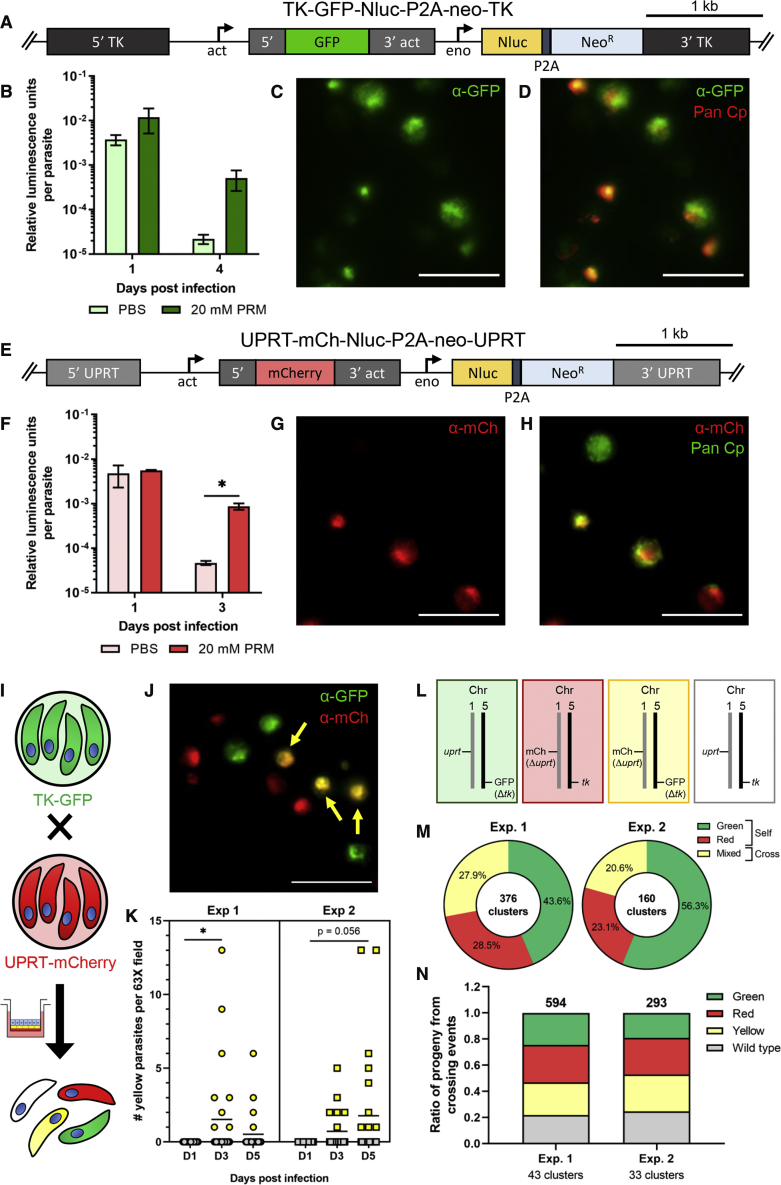
ALI Transwells support genetic crosses of C. parvum in vitro(A) Diagram of targeting construct designed to replace the endogenous tk locus (cgd5_4440) with GFP and Nluc-P2A-NeoR cassette.(B) Relative luminescence normalized to total number of parasites in ALI transwells at 1 and 4 days post infection (dpi). Transwells were infected with ∼1 × 107 unfiltered sporozoites that were electroporated with the TK-GFP-Nluc-P2A-neo-TK reporter and a Cas9 plasmid with a TK gRNA. Transwells were cultured in medium containing PBS (light green) as a control or 20 mM paromomycin (PRM, dark green). Data plotted as mean ± S.D. from two transwells per time point from a representative experiment. Nonsignificant (p = 0.11), unpaired Student’s t test between PBS and PRM-treated transwells 4 dpi.(C) Image of whole-mount ALI transwells 5 dpi with transfected C. parvum from same experiment as (B) stained with anti-GFP followed by goat anti-rabbit IgG Alexa Fluor 488. Scale bar, 10 μm.(D) Merged image of (C) with a Pan Cp polyclonal antibody, which recognizes all C. parvum stages, followed by goat antirat IgG Alexa Fluor 568. Scale bar, 10 μm.(E) Diagram of targeting construct designed to replace the endogenous uprt locus (cgd1_1900) with mCherry and Nluc-P2A-NeoR cassette as (A).(F) Relative luminescence normalized to total number of parasites in ALI transwells at 1 and 3 dpi. Transwells were infected with ∼1 × 107 unfiltered sporozoites per transwell that were electroporated with the UPRT-mCh-Nluc-P2A-neo-UPRT reporter and a Cas9 plasmid with a UPRT gRNA. Transwells were cultured in medium containing PBS (pink) as a control or 20 mM PRM (red). Data plotted as mean ± S.D. from two transwells per time point from a representative experiment. ∗p < 0.05, unpaired Student’s t test between PBS and PRM-treated transwells 3 dpi.(G) Image of whole-mount ALI transwells 5 dpi with transfected C. parvum from same experiment as (G) stained with anti-mCherry followed by goat antirat Alexa Fluor IgG 568. Scale bar, 10 μm.(H) Merged image of (G) with Pan Cp polyclonal antibody followed by goat anti-rabbit IgG Alexa Fluor 488. Scale bar, 10 μm.(I) Diagram of crossing experiments in vitro in which TK-GFP oocysts (green) and UPRT-mCh oocysts (red) are added to the same ALI Transwell.(J) ALI transwells were infected with TK-GFP and UPRT-mCh oocysts (2.5 × 104 unfiltered oocysts per strain) and stained 5 dpi with anti-GFP followed by goat anti-rabbit Alexa Fluor IgG 488 and anti-mCherry followed by goat antirat Alexa Fluor IgG 568. Parasites that express both markers (yellow arrows). Scale bar, 10 μm.(K) ALI transwells were infected with TK-GFP and UPRT-mCh oocysts (5 × 104 unfiltered oocysts per strain) and stained with antibodies as in (J). Images of 13 – 26 fields at 63× were acquired for 1–2 transwells per time point, and the number of parasites expressing both markers per field was counted for two independent experiments. ∗p < 0.05, nonparametric Kruskal-Wallis test with a Dunn’s multiple comparison test.(L) Predicted segregation patterns for chromosomes following meiosis.(M) ALI transwells were infected as in (K). After one round of oocyst formation (3 dpi), transwells were scraped, bleached, and added to HCT-8 monolayers for 15 – 18 hr post infection (hpi), then fixed and stained with the same antibodies as (J) plus mouse monoclonal 1E12 followed by goat antimouse IgG Alexa Fluor 647 to detect wild type parasites. Pie chart shows the percentage of all green, all red, or mixed clusters for two independent experiments. Observed ratios significantly deviate from the expected 50% for mixed clusters, 25% each for green and red (p < 0.001, Chi-square test).(N) Bar graph of the ratio of parasites with each phenotype to the total number of parasites within the “mixed” clusters from the same two independent experiments as in (M). Observed ratios do not significantly deviate from the expected 25% for each phenotype (p = 0.14 for Exp. 1 and p = 0.09 for Exp. 2, Chi-square test). See also Figure S7.